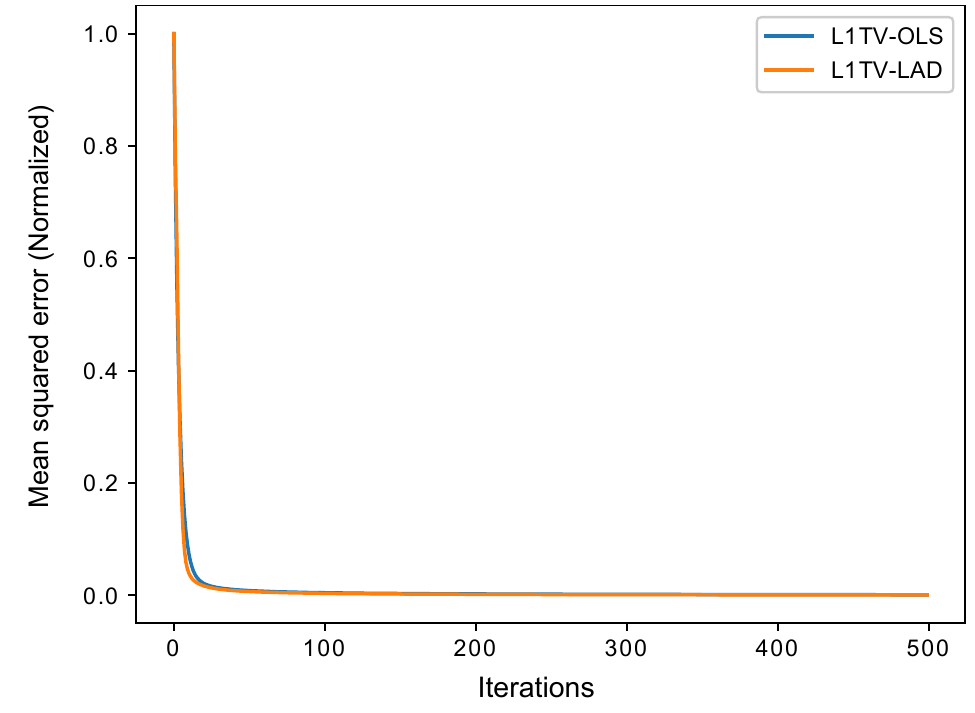
Figure 7. Simulated results of a 3D phantom. ( A ) The volume rendering of the 3D phantom. The cutting plane is set to visually compare the original ( C ) and restored image volumes ( D – F ). ( B ) The random non-Cartesian 3D k -space (sampling ratio = 57.7%). ( C ) The true image. ( D ) Image reconstructed by the conjugate gradient (CG) method. ( E ) L1TV-OLS; ( F ) L1TV-LAD.